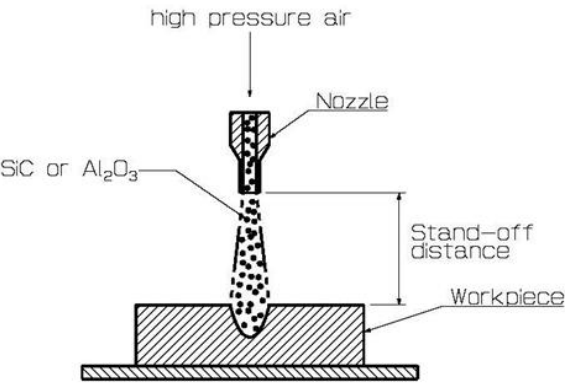
Figure 1. Schematic diagram of micro-abrasive jet blasting.